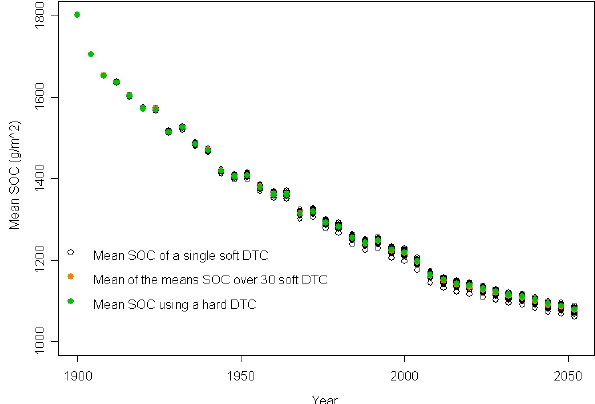
Fig. 7. Mean GEMS modeled soil organic carbon (SOC) computed for the entire study area under the no climate change scenario , from 1900 to 2052 at 4 yearly intervals, using the 9 land cover land uses classes and different Landsat classification approaches. The open circles show the mean SOC for each of the 30 independent bagged decision trees computed using the soft classification-carbon assignment approach; the orange filled circles show the mean across 30 soft classification simulations; the green filled circles show the mean SOC derived simulations using the hard decision tree classi- fication.